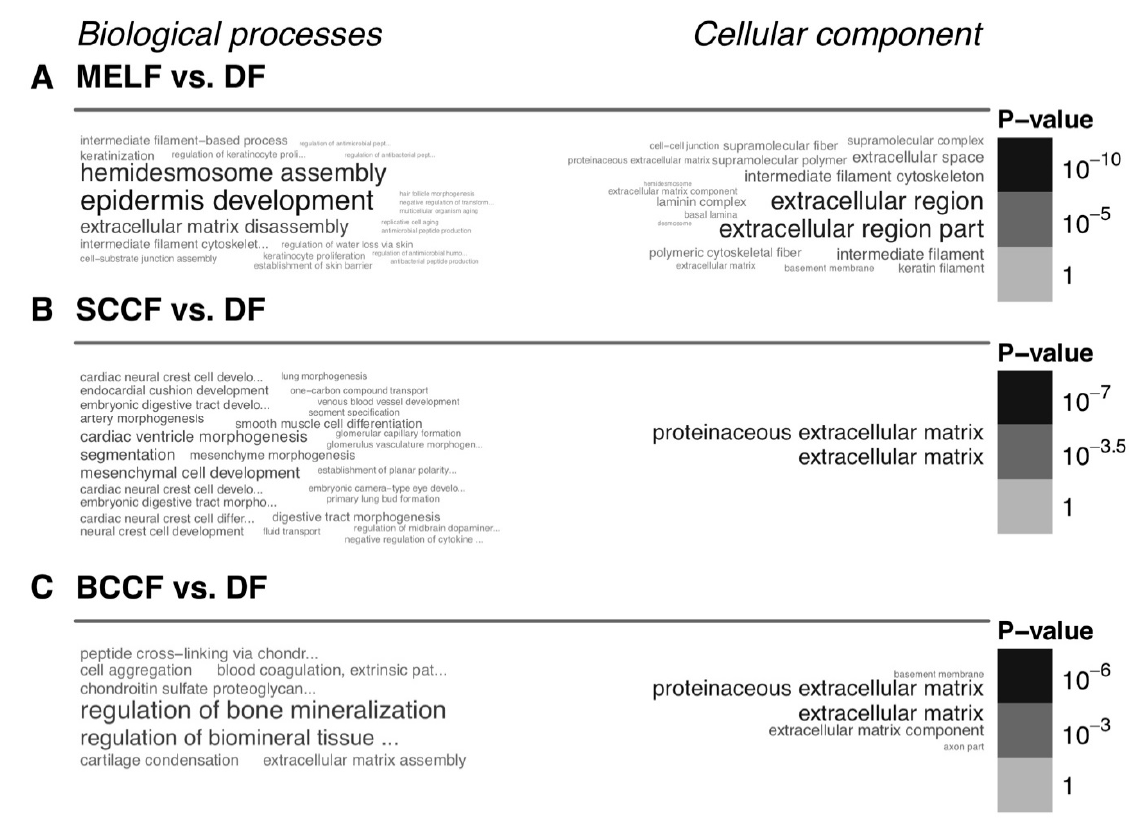
Figure 3. Functional enrichment of the genes differentially expressed between CAF and normal fibroblasts. This figure shows the gene set enrichment analysis using the Gene Ontology terms, where differences between CAF isolated from a skin metastasis of melanoma (MELF, A ), squamous cell carcinoma (SCCF, B ) and basal cell carcinoma (BCCF, C ), and normal dermal fibroblasts from healthy donors (DF, A – C ) are demonstrated. The figure is based on the authors’ data.